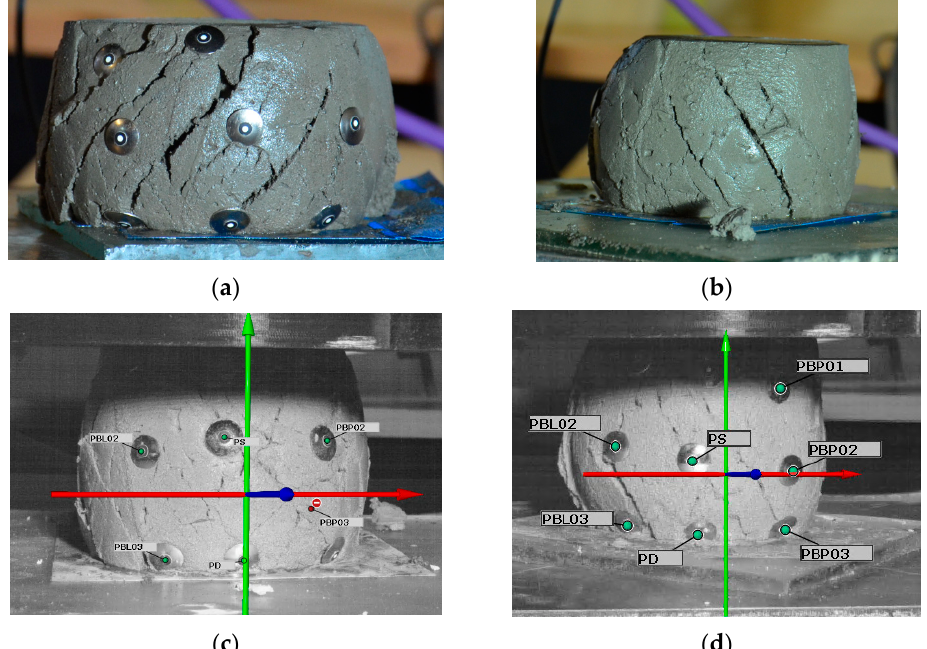
Figure 13. Failure mechanism of specimen: ( a ) Specimen OR50 after test; ( b ) specimen OR0 after test; ( c ) Specimen during the test—beginning of the shearing of specimen—image from the ARAMIS GOM Correlate; ( d ) Sample during the end phase of failure—image from the ARAMIS GOM Correlate. Table 5. Comparison of the maximum compressive stresses (green strength, σ max ) and Young’s Modulus ( E 0.01